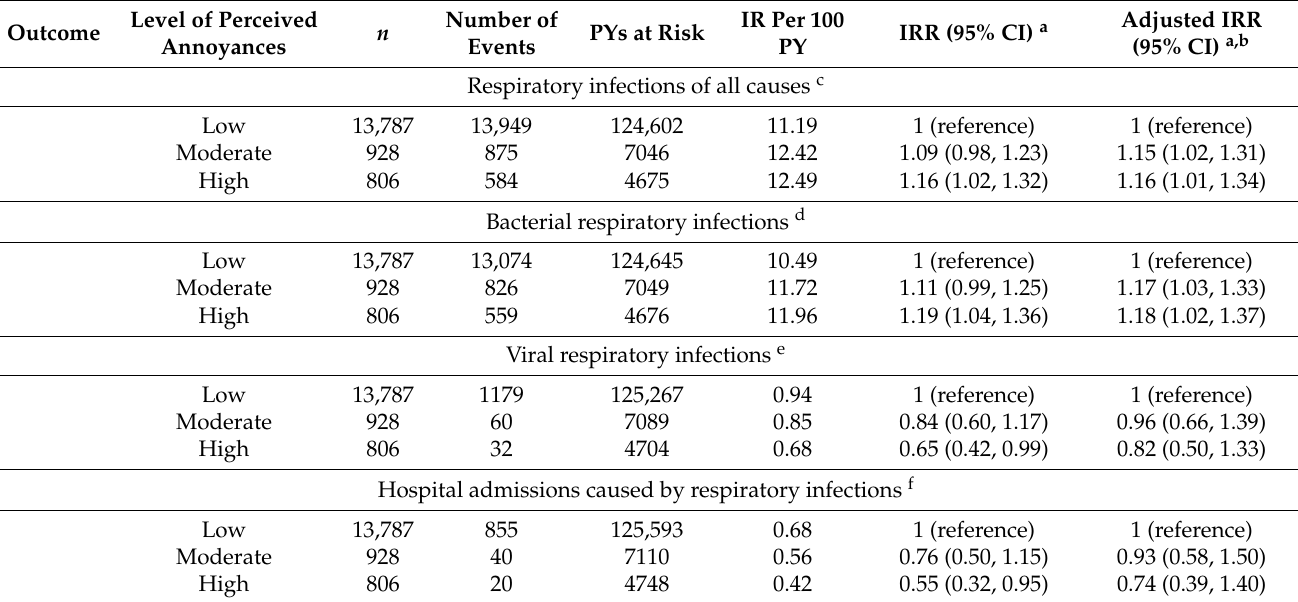
Table 2. Poisson regression of rates of recurrent respiratory infection among participants without asthma or COPD from the Danish Health and Morbidity Survey